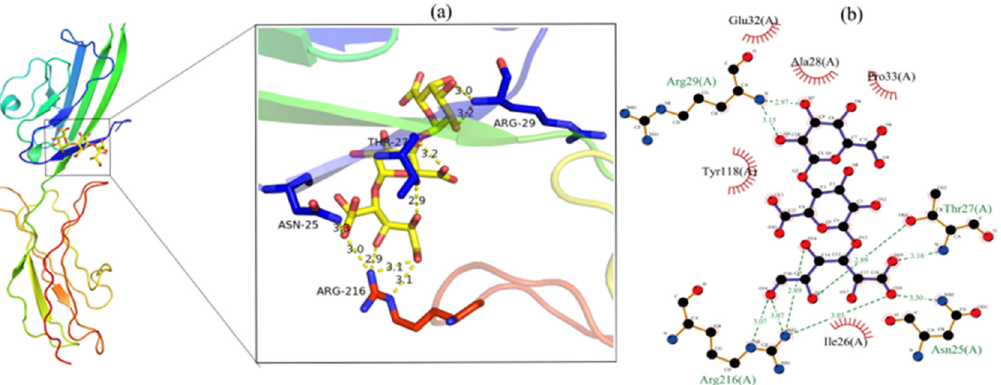
Figure 6. The molecular docking results; ( a ) 3D plot of the interaction between the GalA and AGE receptor; ( b ) 2D ligand interaction plot of GalA docking with the AGE receptor.